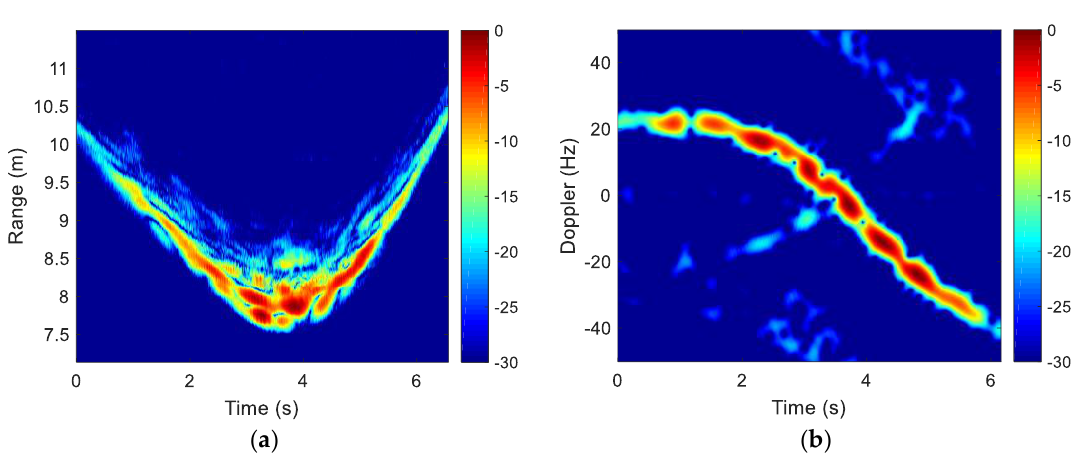
Figure 7. Drone in-flight raw data. ( a ) Range profiles; ( b ) Doppler profiles.